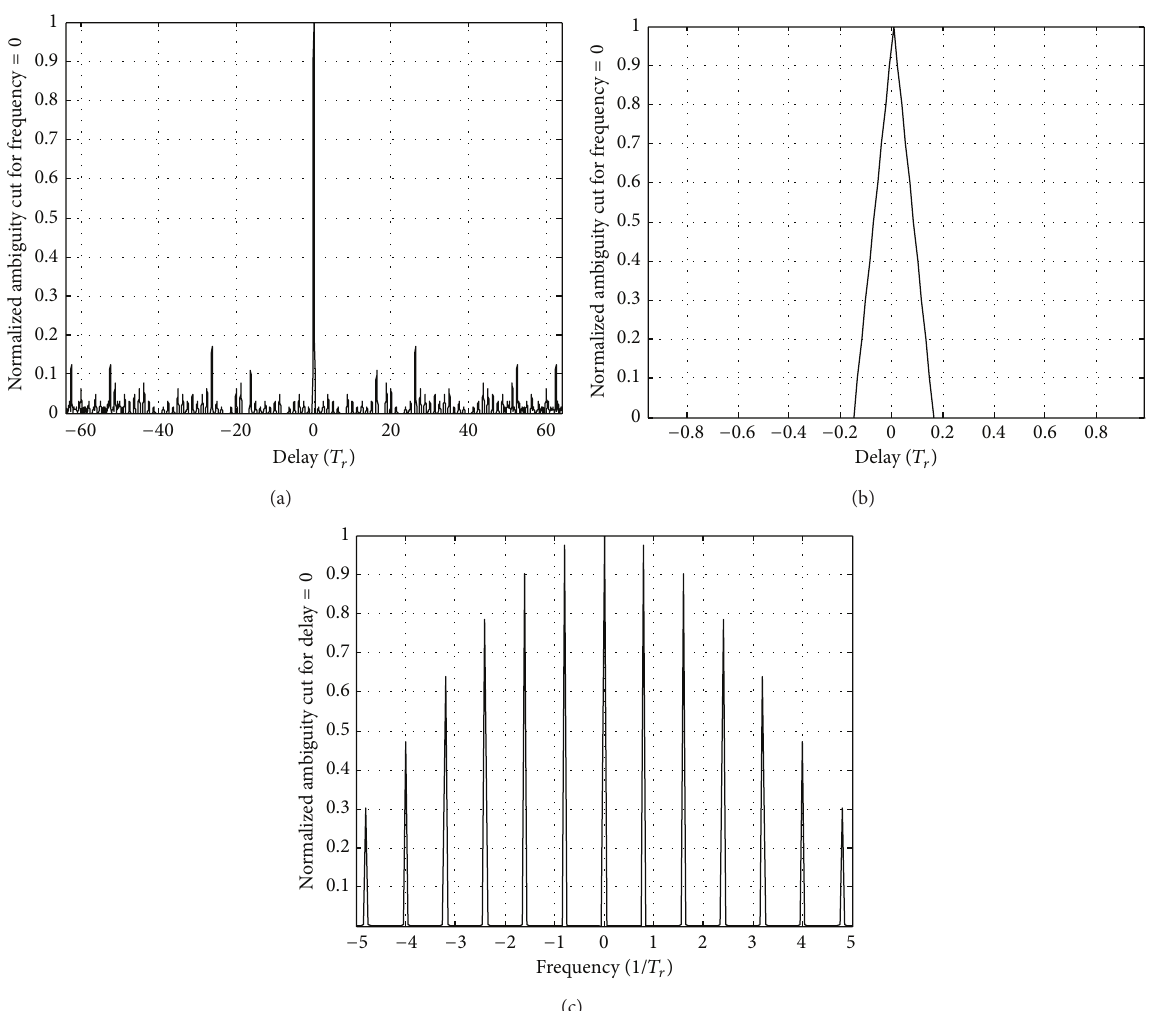
Figure 12: The ranging and velocity ambiguity function for 𝑁 𝑝 = 64 and 𝑇 𝑟 = 4𝑡 𝑝 .